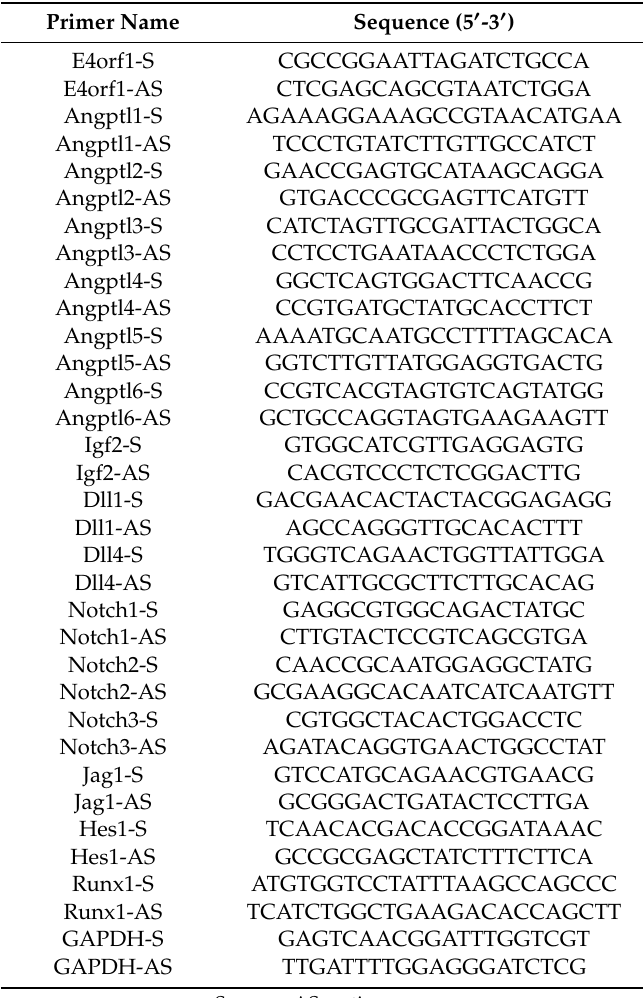
Table 1. Primers used for real-time